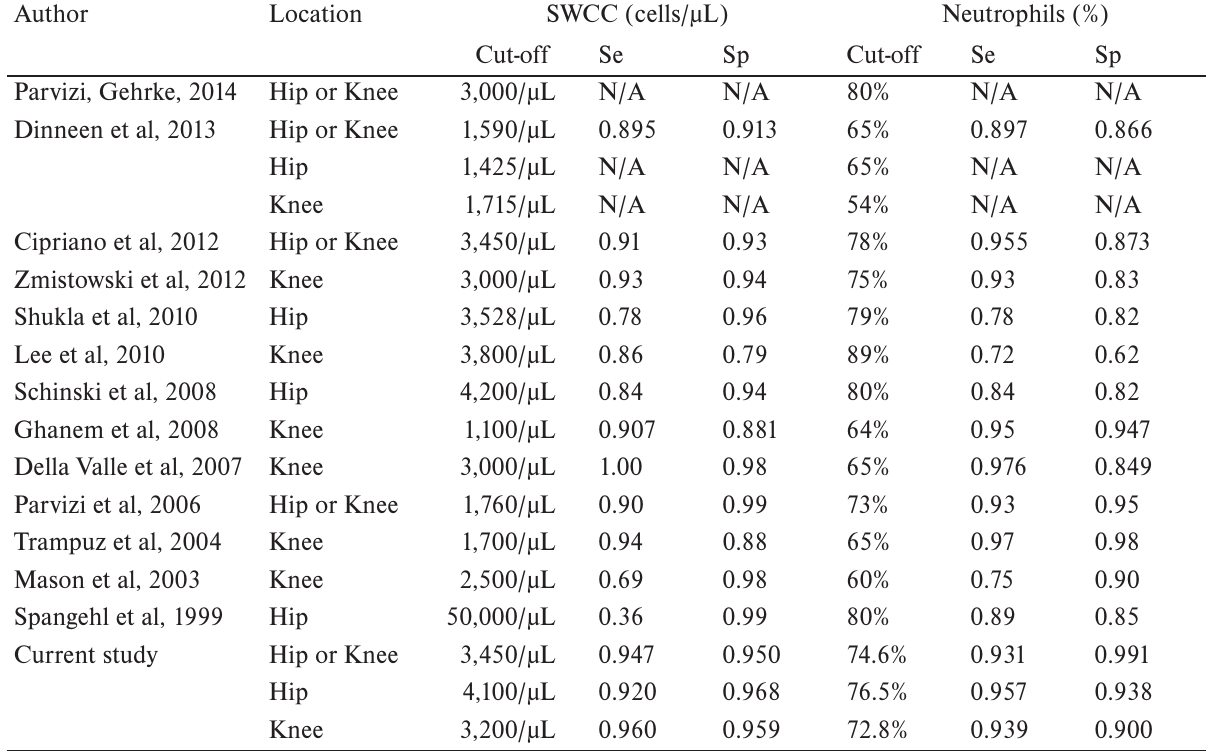
Table 4. Showing the cut-off points for PJI diagnosing in several preceding